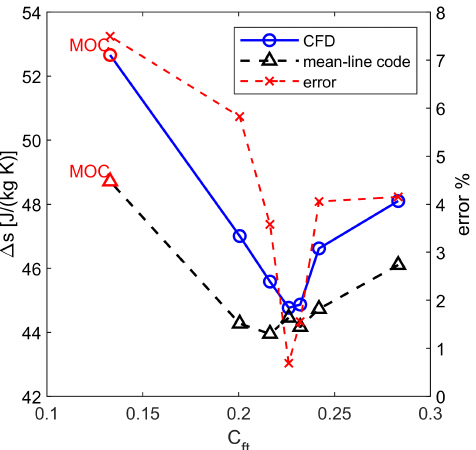
Figure 11. Entropy produced by stator at variable C ft : in blue, values from CFD; in black, value from mean-line code results; in red, CFD-mean-line percentage